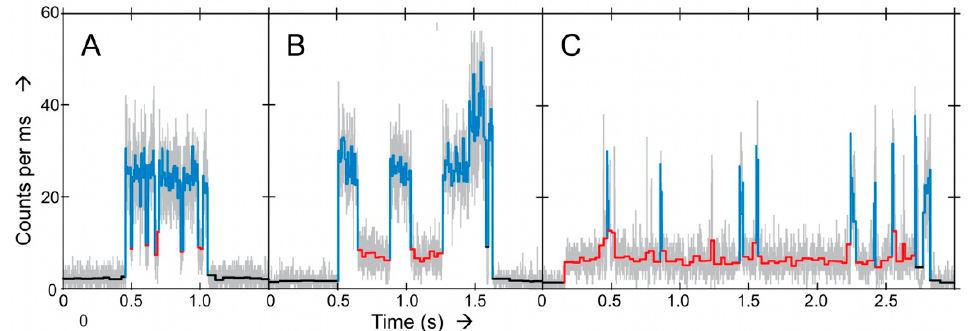
Figure 7. Panels A – C represent examples of intensity-time traces of three different Ax-NiR-A647N molecules trapped in solution with different turnover behavior [7]. Grey traces represent the 1 ms binned data. In color the results obtained from applying a change-point-finding algorithm as a filter on time-tagged data. Three levels were found: upper level corresponding to the reduced form (light blue), a lower level corresponding to the oxidized form (red) and the background (black). Conditions: ascorbate 5 mM; PES, 100 nM; and nitrite 5 mM. Copyright 2011 National Academy of Sciences